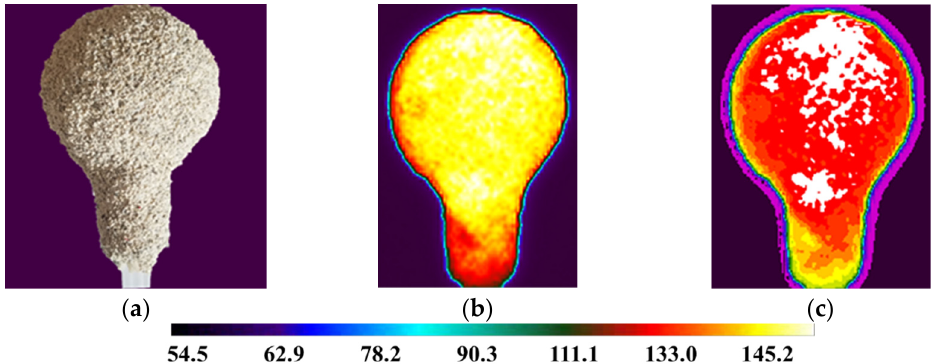
Figure 11. M1 sample ( a ); sample thermogram M1 obtained directly from the camera ( b ); defectogram of M1 sample with a temperature map scale ( c ).